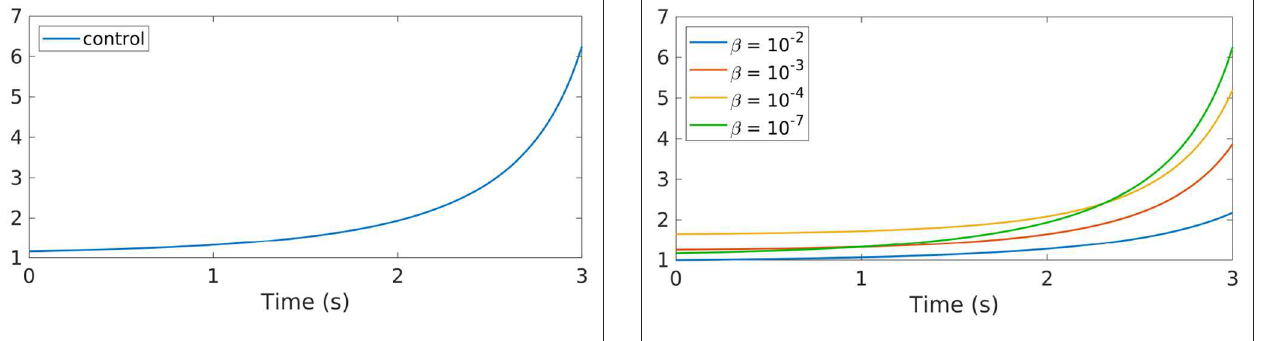
u obtained through the GD-RBM algorithm 10 oscillators and = b